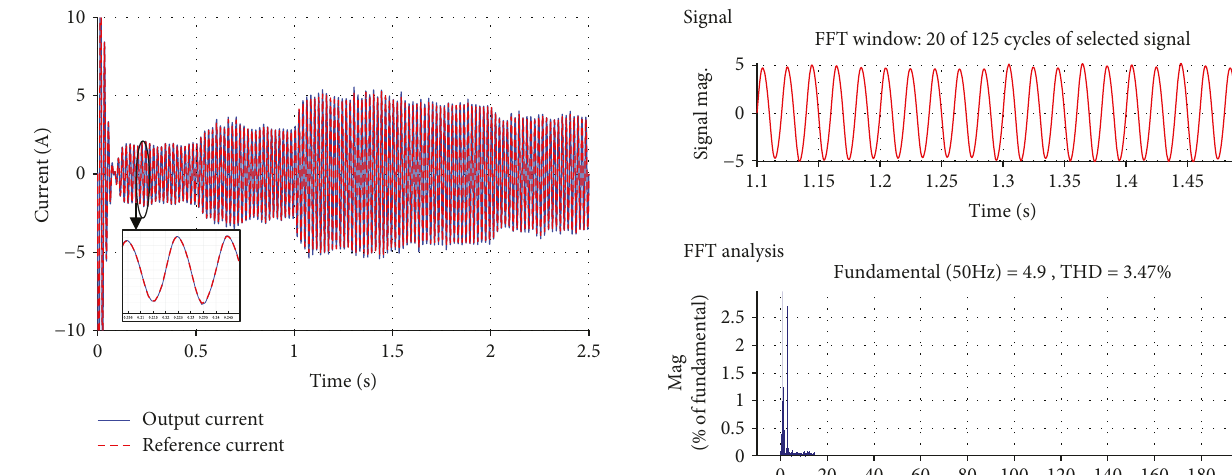
FFT window: 20 of 125 cycles of selected signal